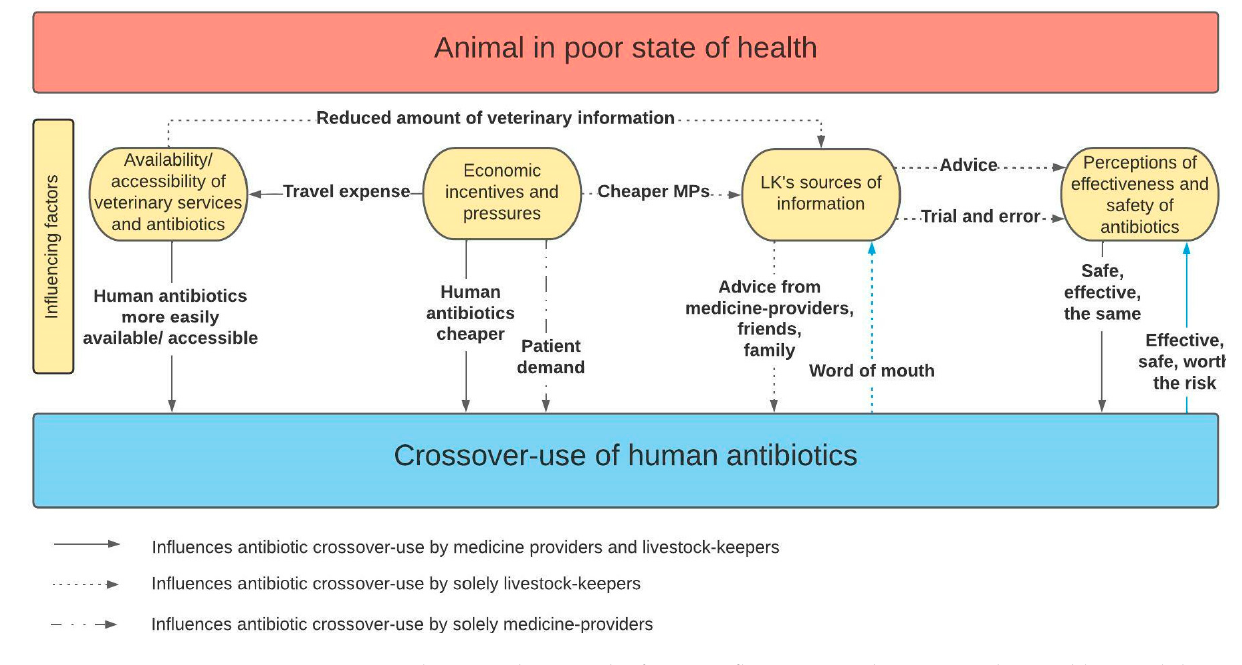
Figure 1. Schematic showing the factors influencing medicine-providers and livestock-keepers in partaking in the practice of crossover-use.